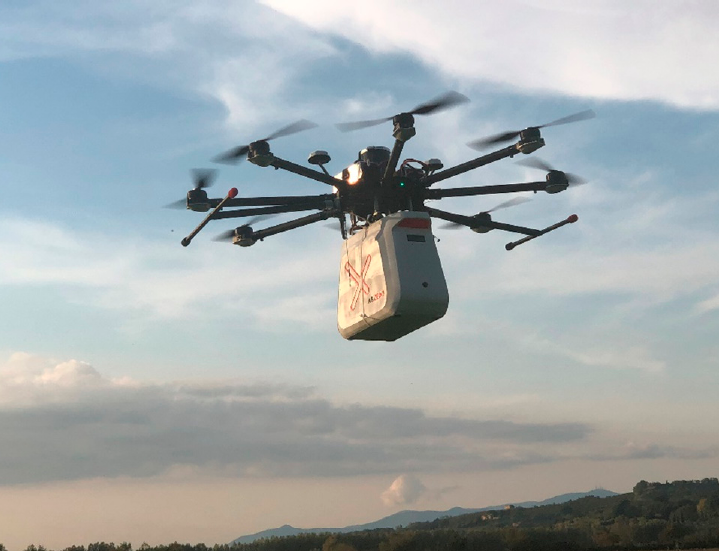
Figure 3. A flight fully supervised by the Smart Capsule AI during experimentation.